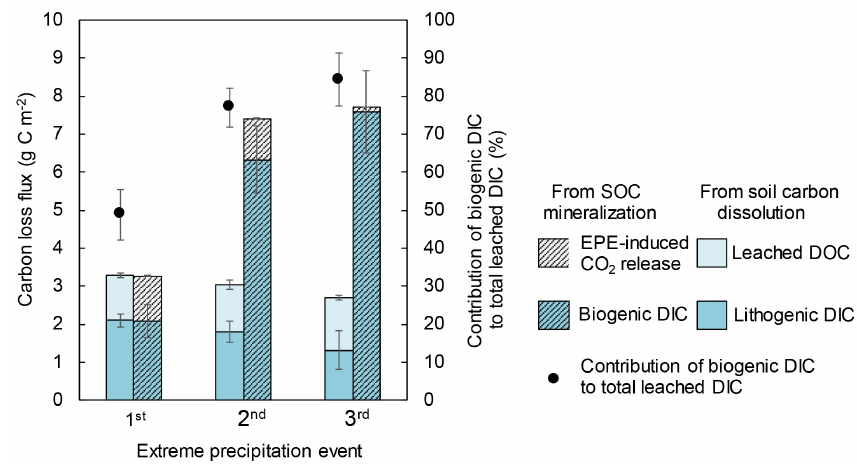
Figure 5. Carbon loss fluxes from soil organic carbon (SOC) mineralization in the non-amended XLHT soils. Fluxes include EPE-induced CO 2 release and leaching of biogenic dissolved inorganic carbon (DIC), dissolved organic carbon (DOC), and lithogenic DIC. Mean values are shown with standard error ( n =